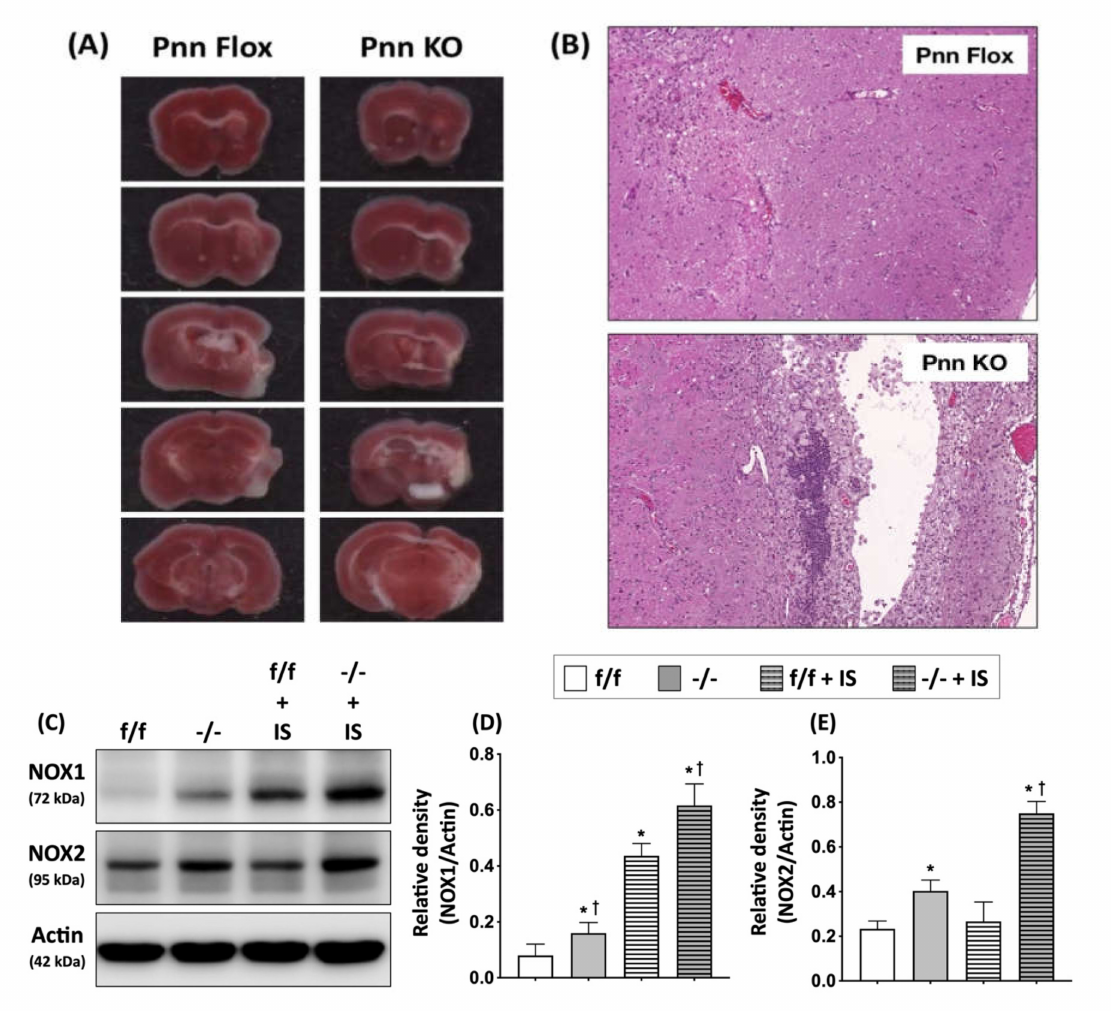
Figure 6. Neuronal Pnn depletion exacerbating brain infarction in mice with cerebral is- chemia/reperfusion injury. ( A ) 2,3,5-triphenyltetrazolium chloride (TTC) staining was performed on cerebral slices to identify infarcted region. White color indicates a loss of dehydrogenase activity in the infarcted region. ( B ) To determine the cerebral infarction high-power field, a histopathological examination with H&E staining was performed on cerebral sections. ( C ) Western blotting to ex-amine the expression of NOX-1 and NOX-2 in peri-infarct cortex. ( D ) Comparison of protein levels of NOX-1 in peri-infarct cortex. ( E ) Comparison of protein levels of NOX-2 in peri-infarct cortex. A significant loss of brain tissues, infiltration of immune cells, and increased level of NOXs were observed in mice with neuronal Pnn depletion and ischemic stroke. f/f, flox/flox mice. -/-, mice with homozygous neuronal Pnn deficiency. IS, ischemic stroke. NOX-1, NADPH oxidase 1. NOX-2, NADPH oxidase 1. n = 4 for each group. * indicates significance compared with f/f group. † indicates significance compared with f/f + IS